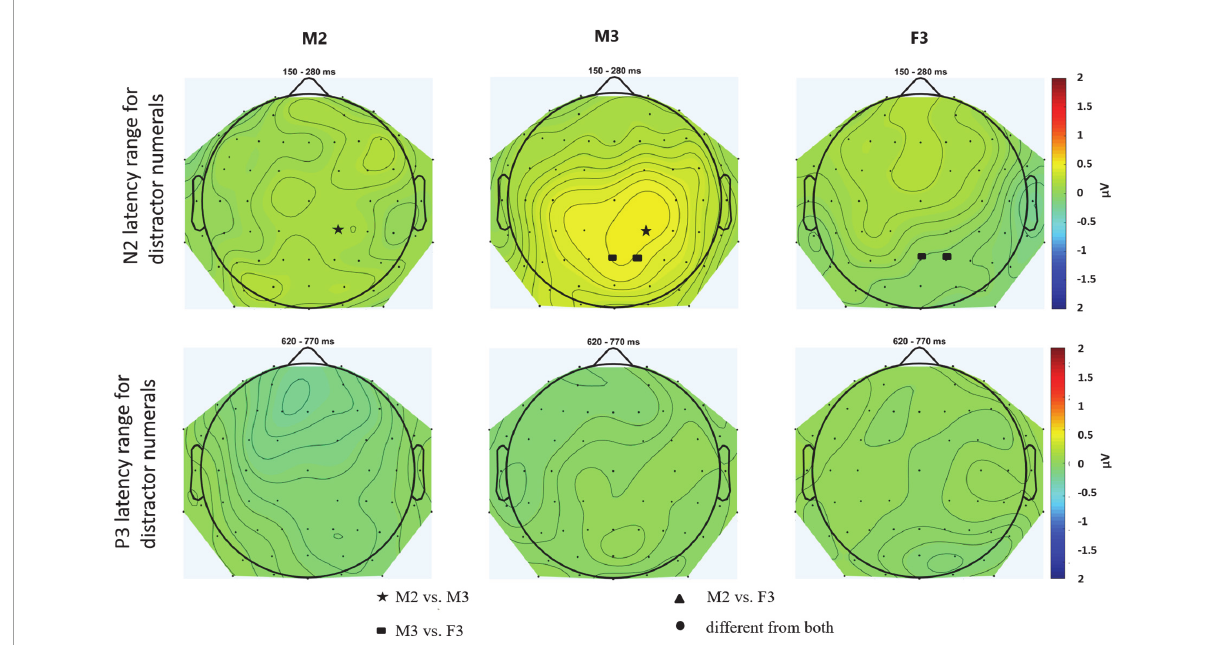
FIGURE4 Scalp topography of the N2 (upper row) and P3 (bottom row) latency range for distractor numerals for the three distractor streams: M2 – male speaker in the one-distractor condition, M3 – male speaker in the one-distractor condition, F3 – female speaker in the two-distractor condition. The scalp distributions were calculated from the average voltages measured from the time windows shown in Figure 2 . Maps were spline interpolated with a smoothing factor of 10 − 7 . Electrode locations marked by filled circles, stars, triangles, and rectangles represent the scalp locations where the signal in the given latency range significantly differed from one (filled stars, rectangles, or triangles) or both (circles) other conditions. Tests were computed by pair-wise post hoc comparisons of the corresponding ANOVA with the factors of CONDITION and ELECTRODE LOCATION (including all electrodes; thus replacing the factors ANTERIOR-POSTERIOR and